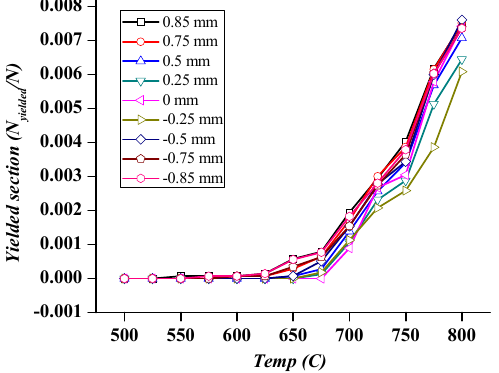
Figure 12. Yielded section under pressure loading for various temperature conditions.